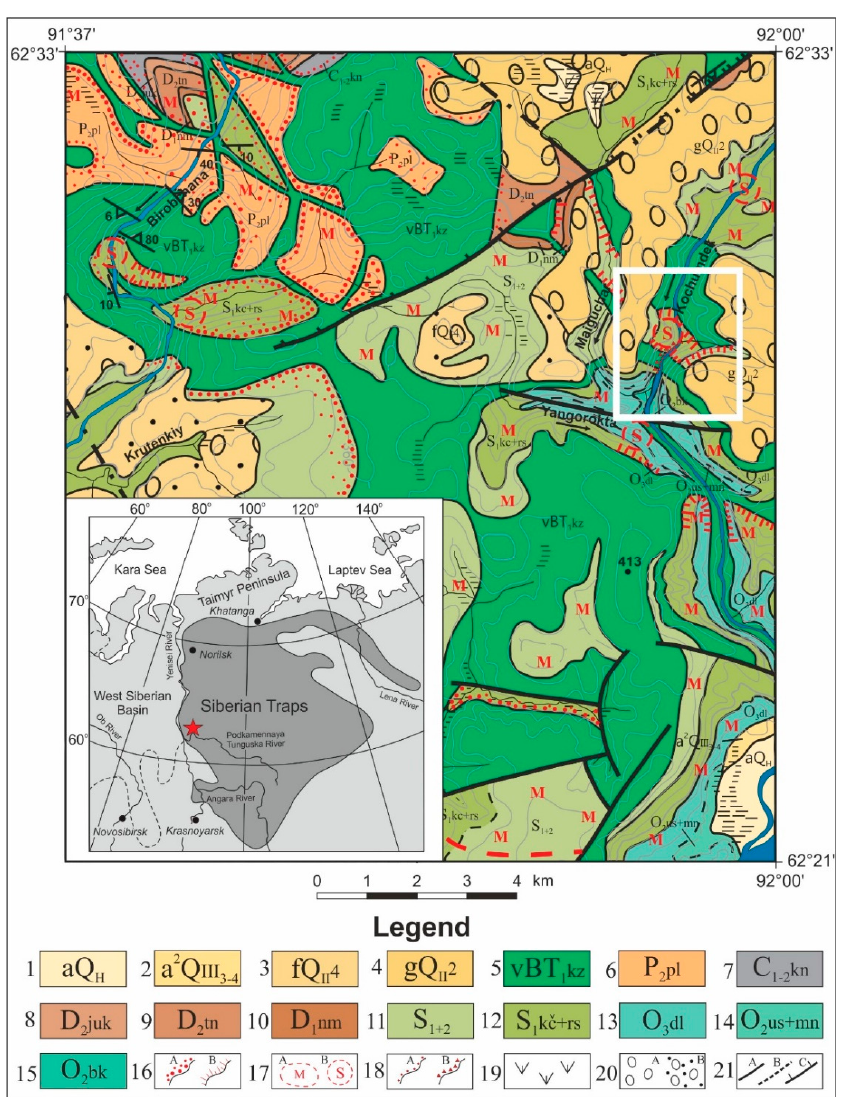
Figure 1. Distribution area of the Siberian flood basalt province (Siberian Traps), after [42], and geological map of the study area (red star and white square), modified after the 1:200,000 State Geological Map [43]. Legend corresponds to the 1:1,000,000 State Geological Map [44]. 1 – 4 = Qua- ternary sediments (alluvium, fluvioglacial and moraine deposits), 5 = Early Triassic intrusions of the Kuz’movsky complex. Sedimentary strata: 6 = Pelyatkinsk Formation (Perm), 7 = Kondrominsk Formation (Carboniferous), 8 = Yukta Formation (Devonian), 9 = Tynep Formation (Devonian), 10 = Nimsky Formation (Devonian), 11 = Lower and upper parts of the Silurian (combined), 12 = Ko- chumdek, Kulina, Razvilkinsk Formations of the Lower Silurian (combined), 13 = Dolborska (Or- dovician), 14 = Uststolbovaya and Mangazeya Formations united (Ordovician), 15 = Baikit For- mation (Ordovician). 16. A = Hornfels, B = Skarny breeds. 17. A = Metasomatic rocks, B = Sulfida- tion. 18. A = 1981 data, B = 2017 data. Quaternary sediments: 19 = Lake-marsh, 20. A = Water-gla- cial, B = Glacial. Tectonic contacts: 21. A = Reliable, B = Alleged, C = Reliable, indicating the direc- tion of incidence of the displacer surface.